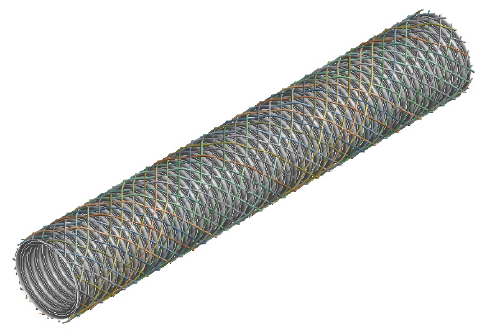
Figure 8. The geometry of the braided corrugated hose. Table 1. Physical properties of 304 stainless steel.